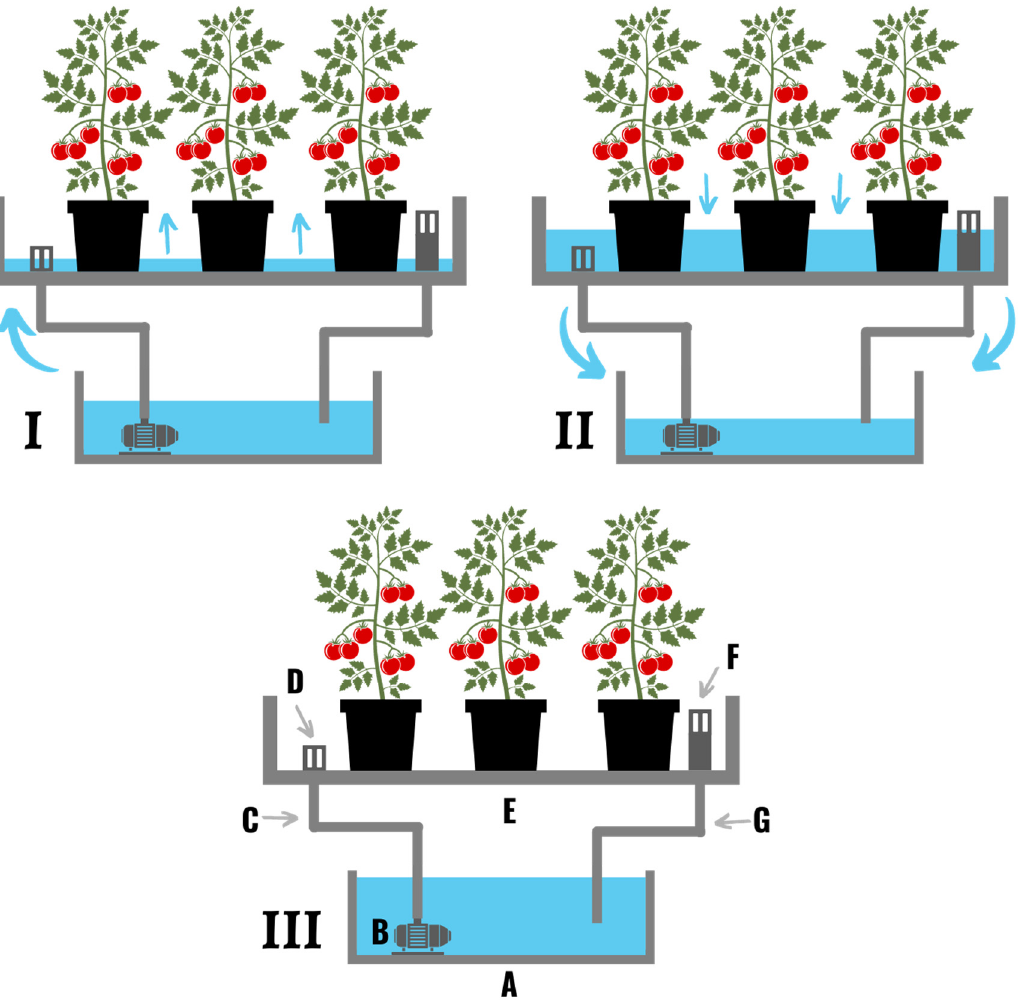
Figure 3. An ebb and flow or flood and drain hydroponic system in which nutrient solution is pumped from an external reservoir ( A ) over the plants at set intervals during the day. ( I ) During the fill stage a timer turns on the pump ( B ), which pumps the nutrient solution up through a pipe or tube ( C ), through the fill inlet/drain ( D ), and into the flood tray ( E ). An overflow drainpipe ( F ) sits several inches above the fill inlet/drain, and prevents the system from overflowing. ( II ) If the tray starts to overflow nutrient solution will return to the reservoir ( A ) through the tube connected to the overflow drainpipe ( G ). Once the pump turns off, the nutrient solution drains back down the fill tube ( C ), through the pump ( B ), and into the reservoir ( G ). ( III ) After the pump turns off the flood table ( E ) drains completely back into the reservoir ( A ) and sits empty until the next pump cycle.